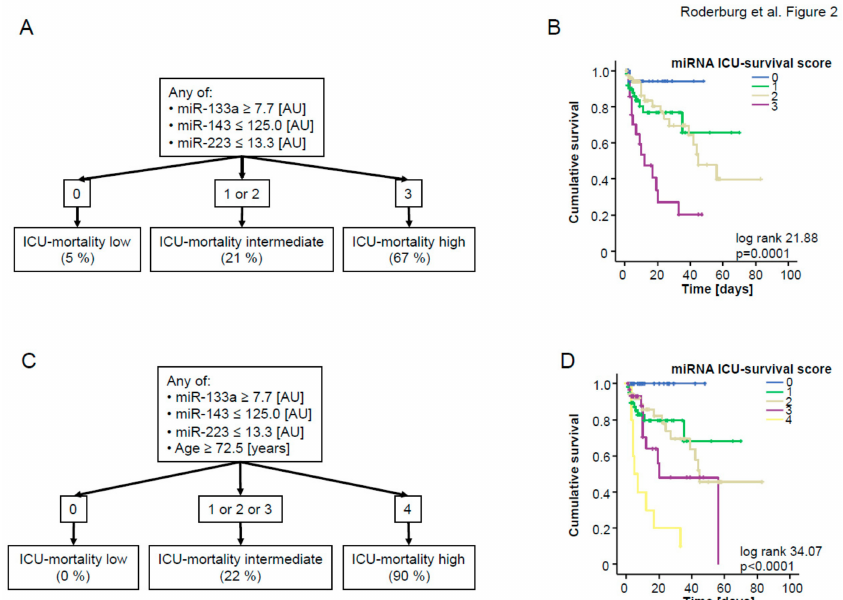
Figure 2. ( A ) The individual “miRNA survival score” was calculated as described in the text. In brief, patients with a higher (in the case of miR-133a) or lower (in the case of miR-143 and miR-223) levels than the respective cut-o ff were given one point for each individual dysregulated miRNA. All points were added to an “ICU survival score”, ( B ) Kaplan–Meier curve analysis of ICU patients demonstrates that patients with a high “ICU survival score” had an increased short-term mortality compared to other patients; p -values are given in the figure. ( C ) Age was included in the “ICU survival score”. Patients older than 72.5 years received one additional point. ( D ) Kaplan–Meier curve analysis of ICU patients demonstrates that patients with higher “ICU survival score + age” had an increased short-term mortality compared to other patients; p -values are given in the